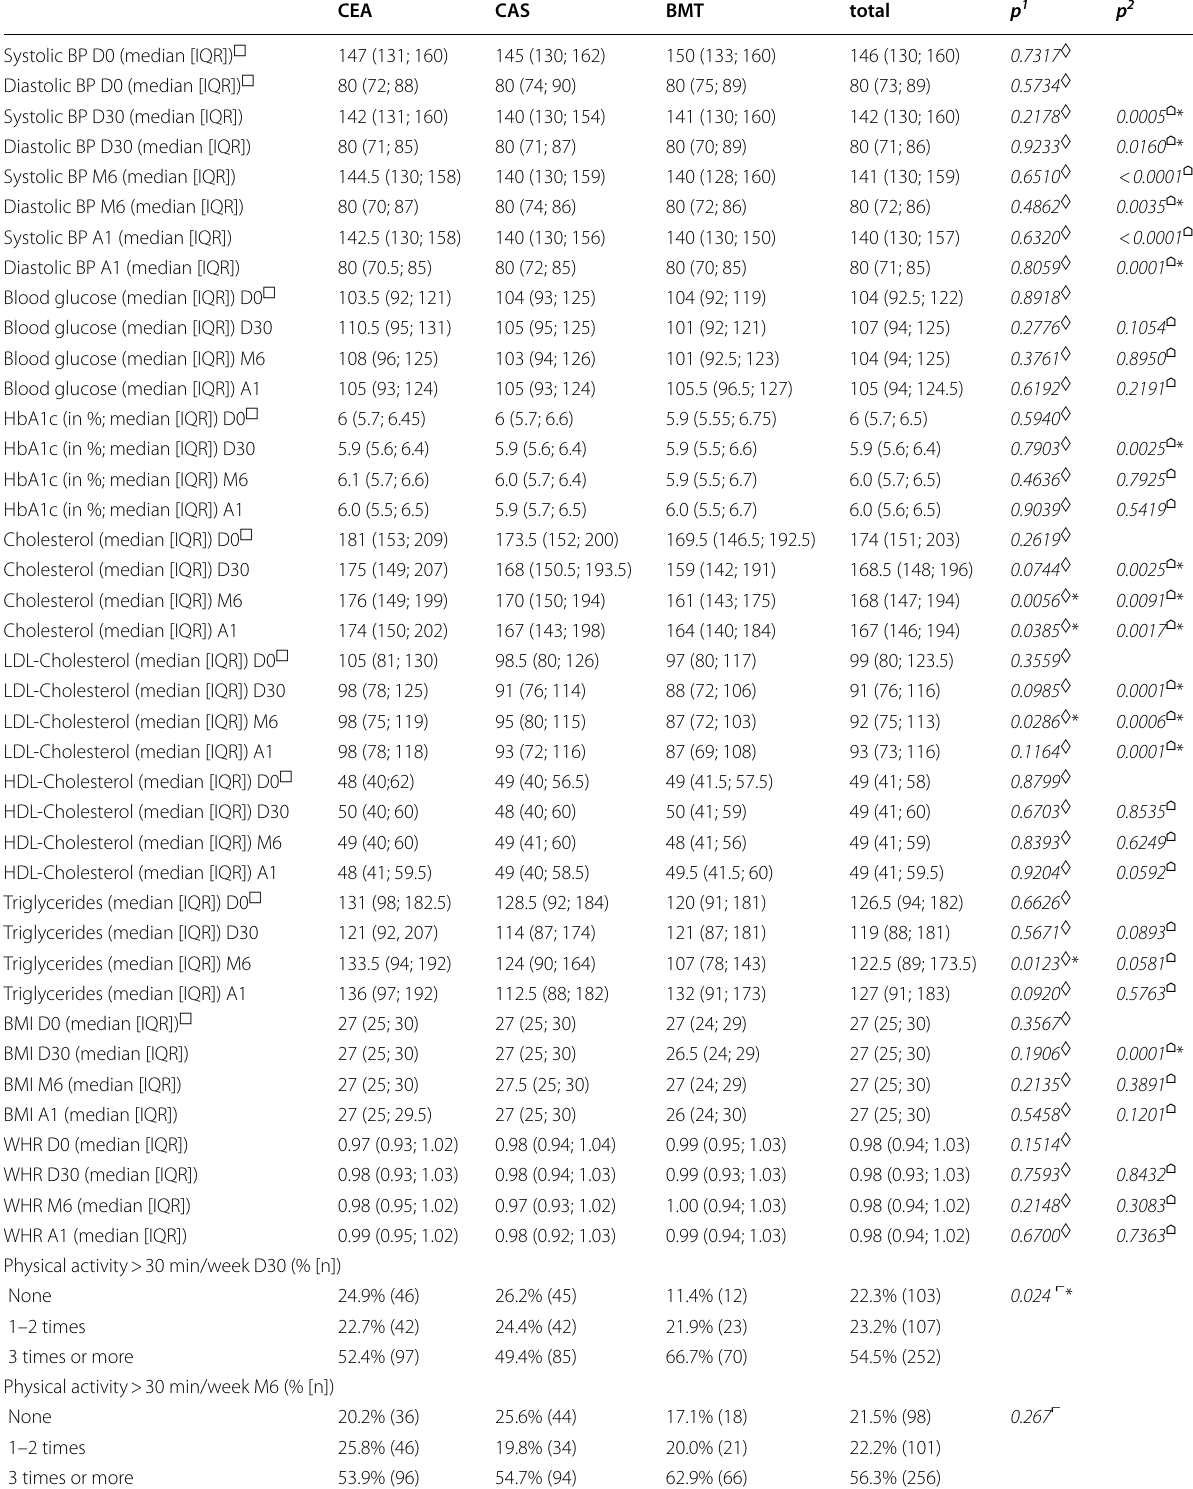
Table 2 Adjustment of vascular risk factors over time and comparison of study groups; n